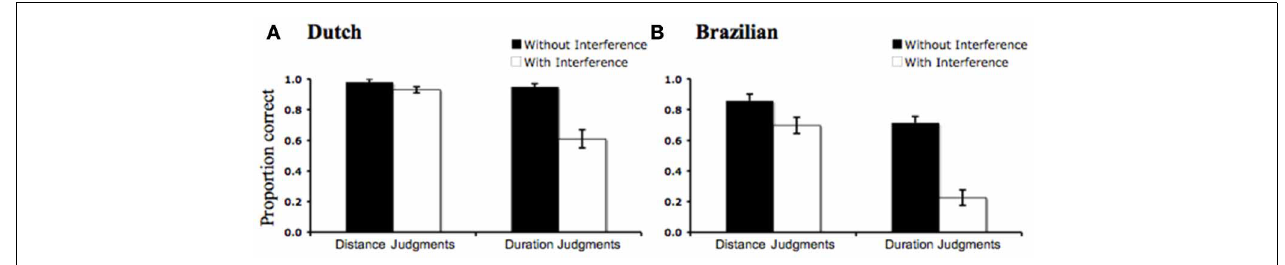
FIGURE 1 | Effect of cross-dimensional interference on spatial and temporal judgments for Dutch (A) and Brazilian (B) children. In both cases the effect of distance interference on duration judgments was greater than the effect of duration interference on distance judgments. Error bars show s.e.m.